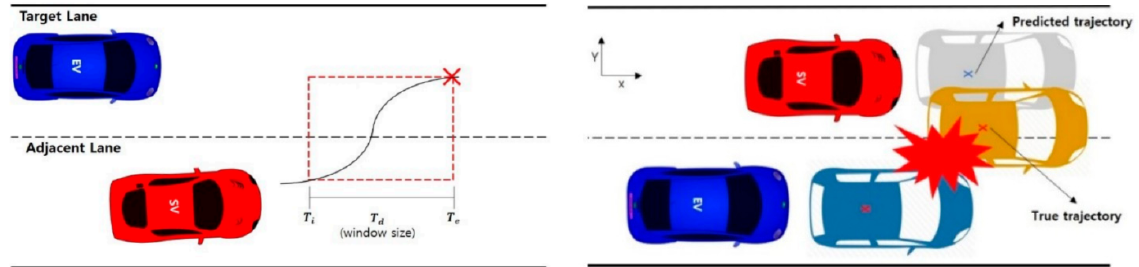
Figure 1. Lane change maneuvers were analyzed by Choi et al. [18] (Image courtesy Open Access—Electronics, MDPI).